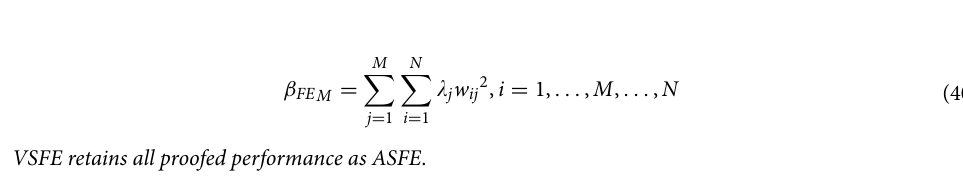
Table 3. Overview of the input IFs. RTS Request to Send, CTS Clear to